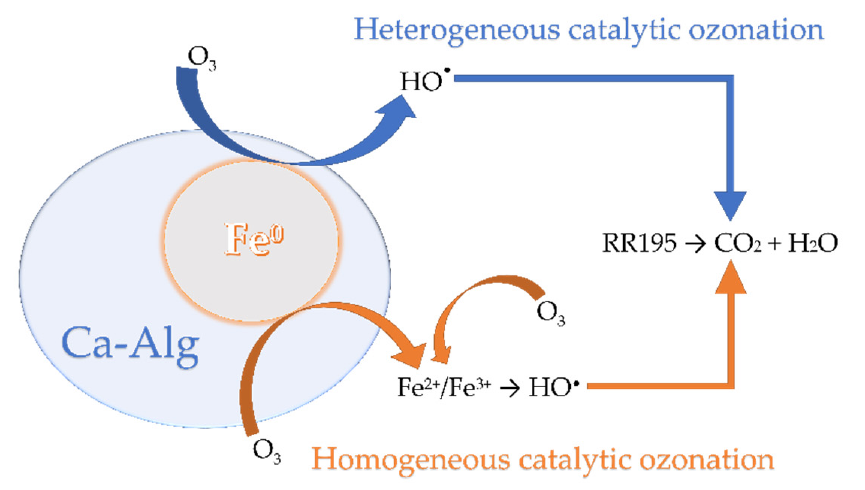
Figure 4. Proposed mechanism of catalytic ozonation of Reactive Red 195 dye using nZVI based on Pereira, 2021 [107].